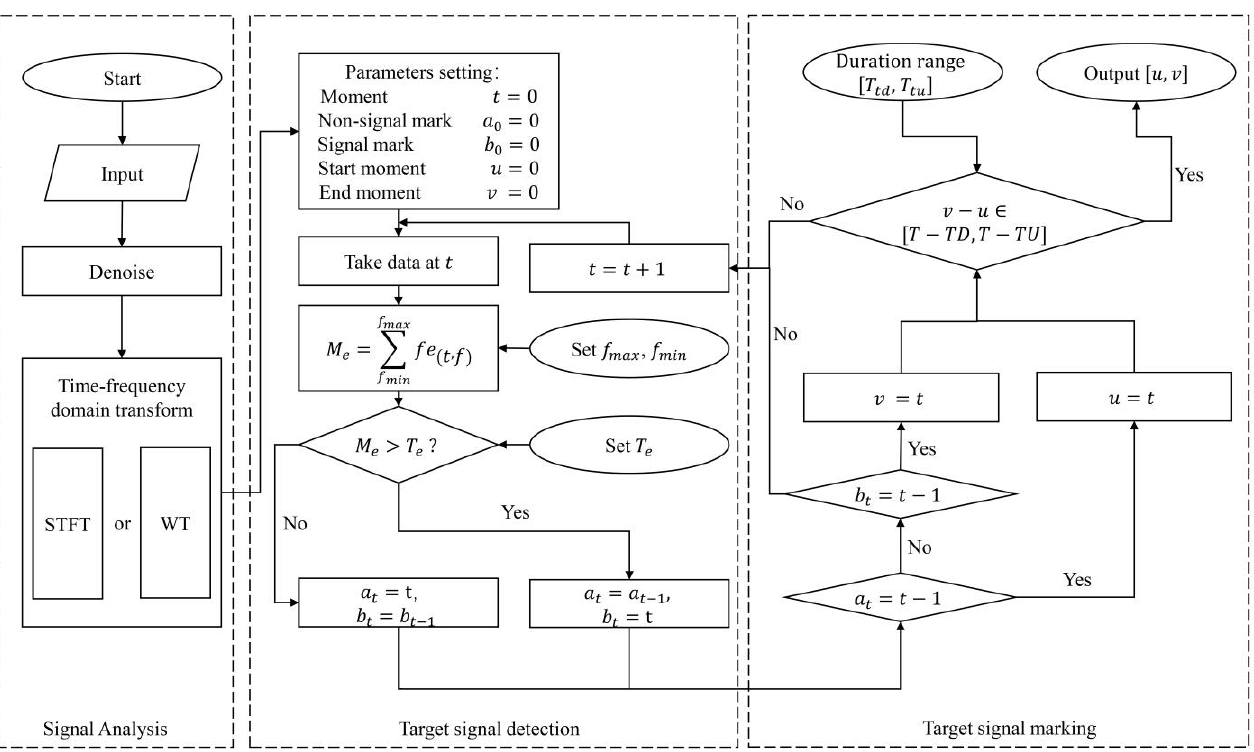
Figure 1. Flow chart of the target signal detection procedure.